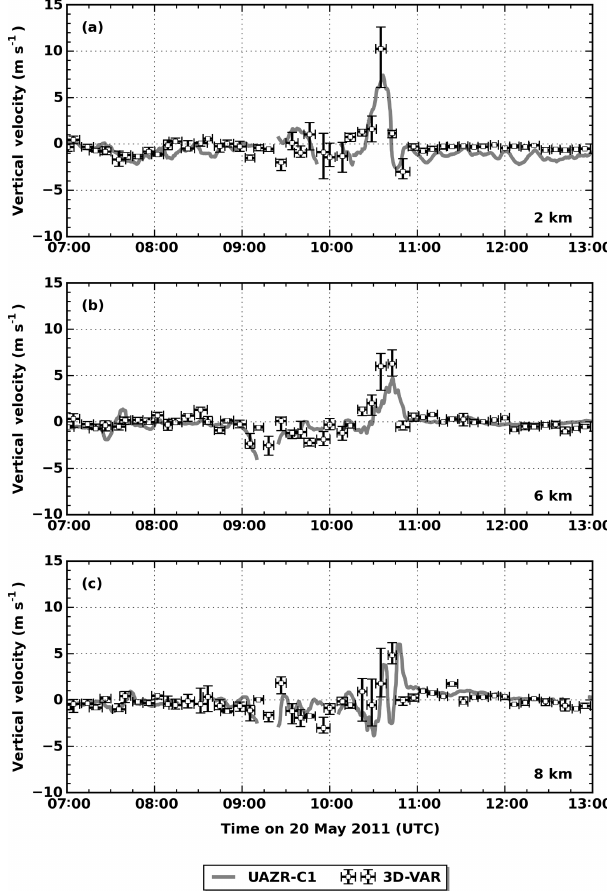
Figure 10. Similar to Fig. 9 but for 20 May